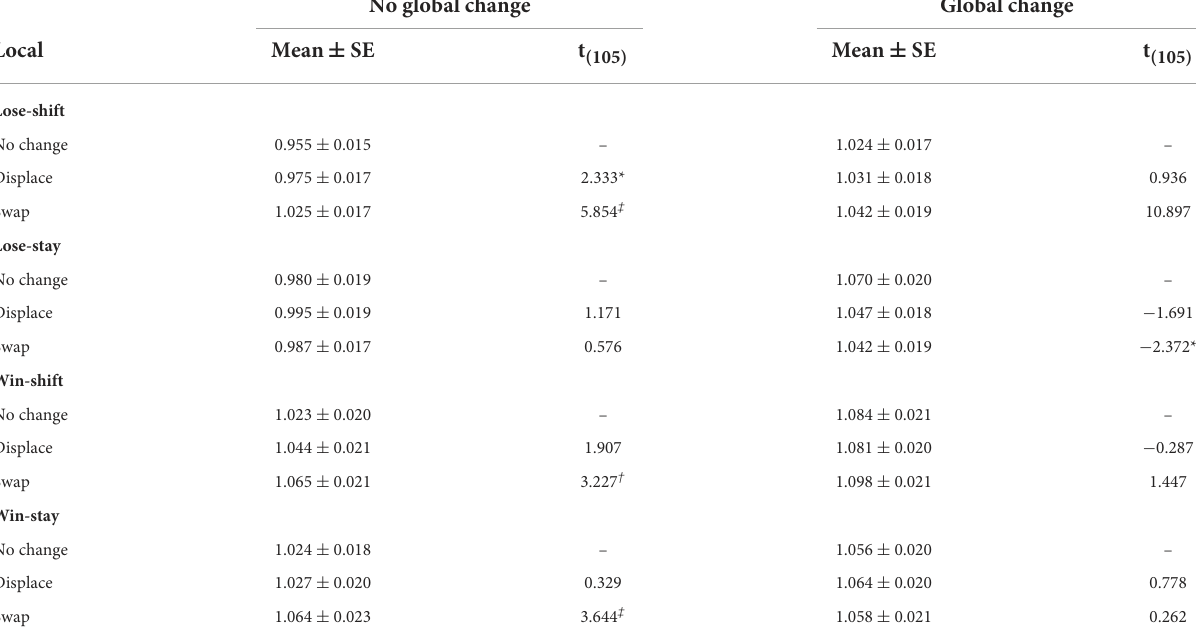
TABLE 3 Mean decision times for lose-shift, lose-stay, win-shift, and win-stay